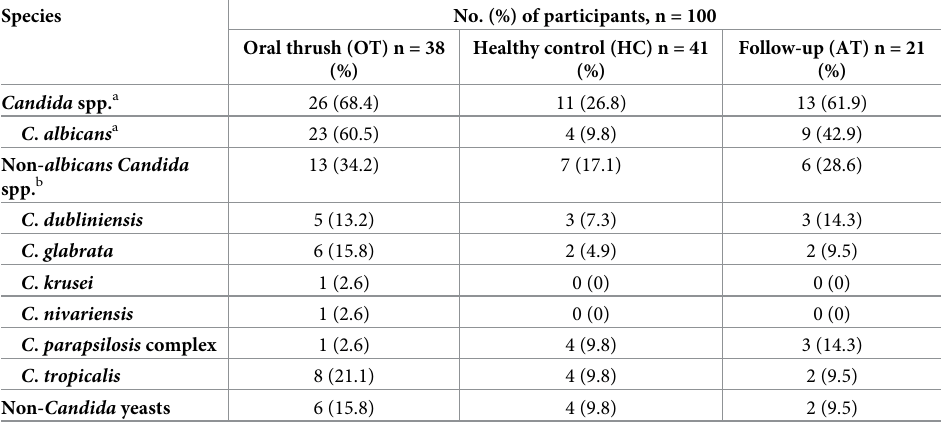
a Presence of Candida and C . albicans were significantly associated with oral thrush status in OT vs. HC groups (p < 0.001) and AT vs. HC groups (p = 0.012; p = 0.006), while it was not for the AT vs. OT groups (p = 1.00; p = 0.375) b Presence of NAC species were not significantly associated with oral thrush status in OT vs. HC groups (p = 0.068), AT vs. HC groups (p = 0.232), and OT vs. AT groups (p =